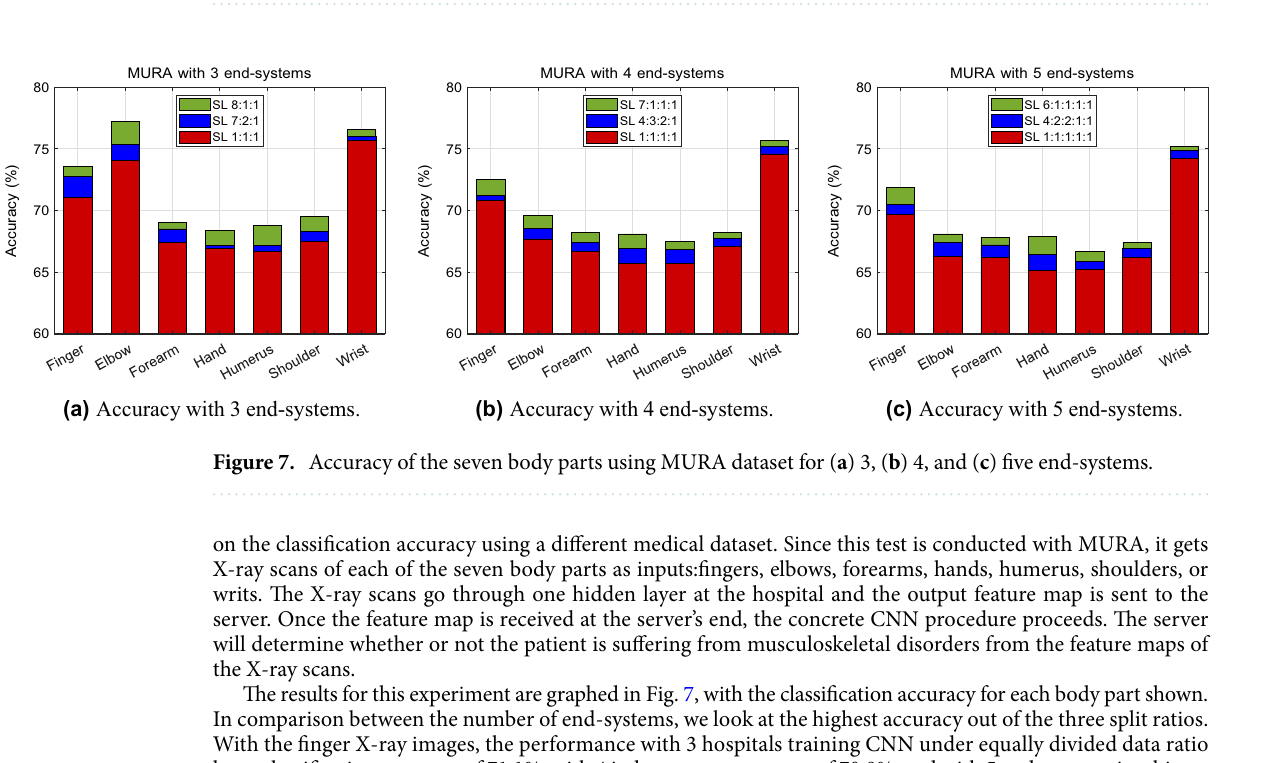
Table 2. Classification accuracy using COVID-19 CT scan.